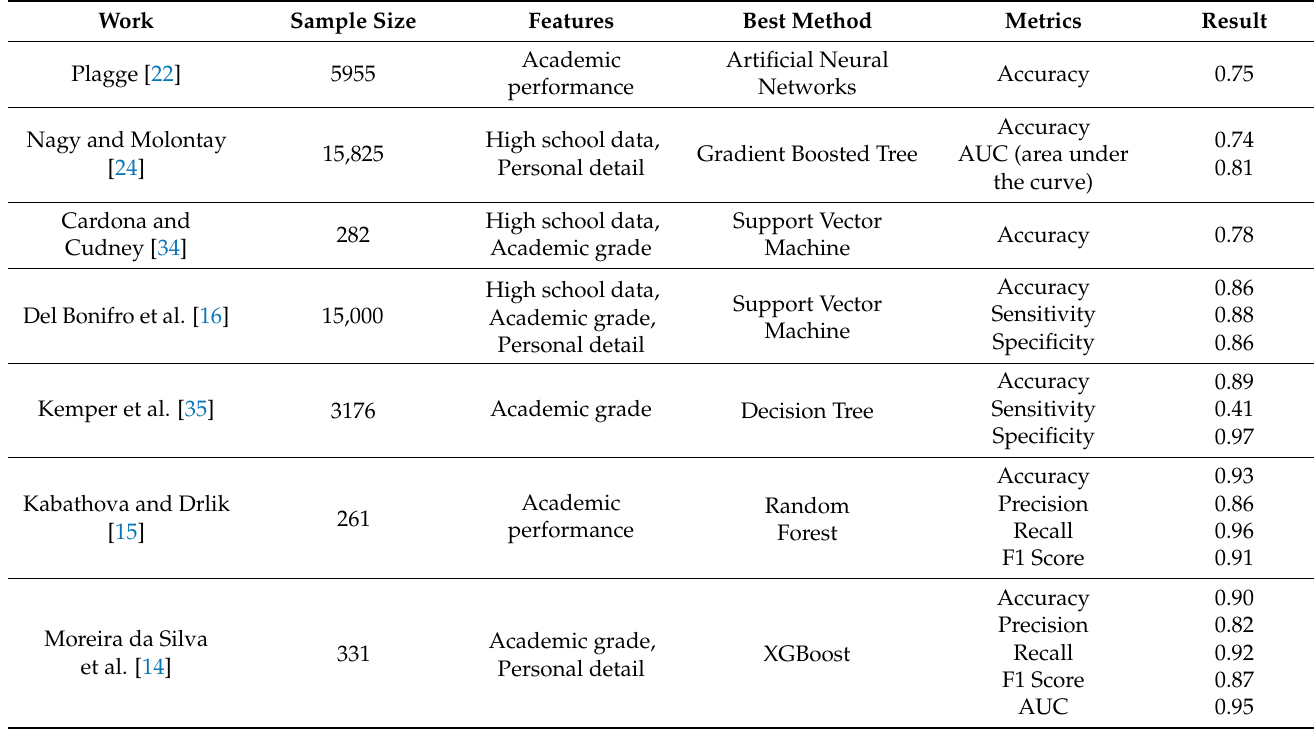
Table 1. Model, Sample Size, Features, and Metrics Used and Results